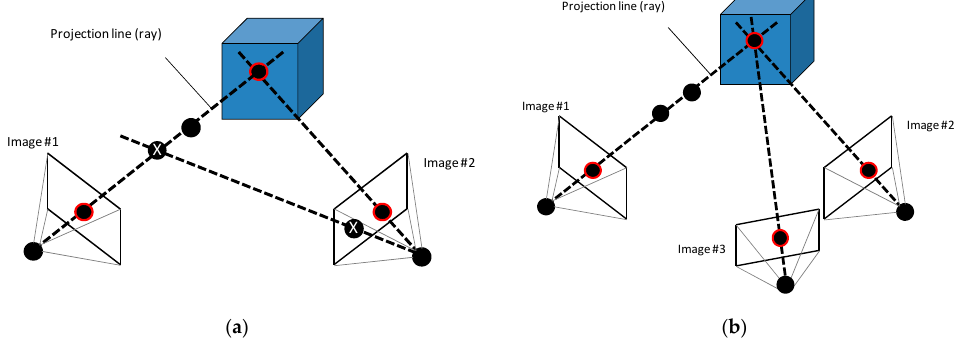
Figure 3. From 2D to 3D. ( a ) Homologous points; ( b ) Intersection of the projection lines.